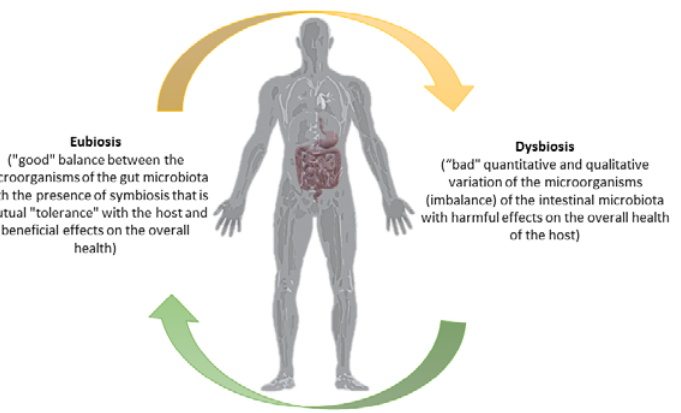
Figure 1. The gut microbiota/host axis depends on the favorable balance between the microorganisms